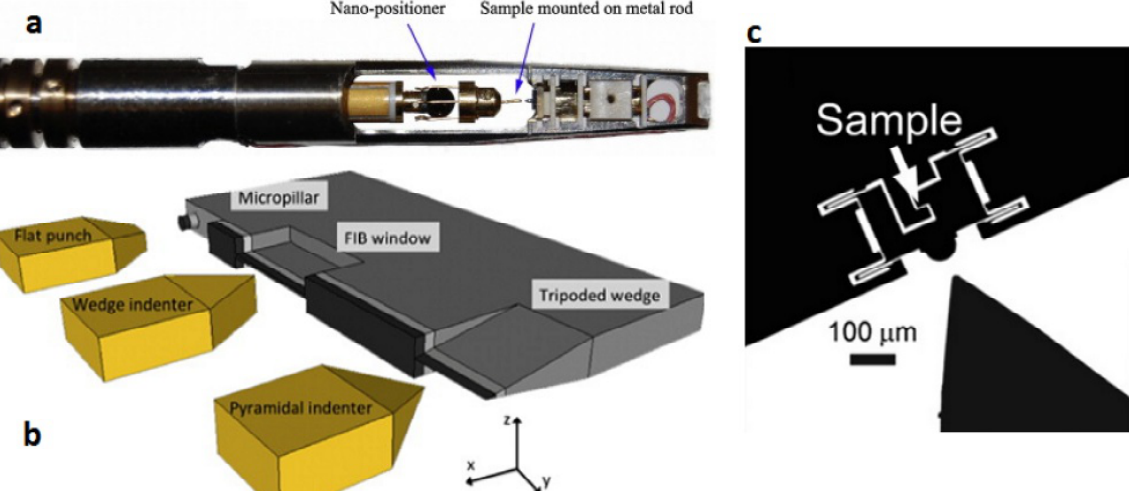
Fig. 4. Examples of in situ TEM mechanical testing techniques: (a) Tip of a classical straining holder (b) sketch of the various types of straining configurations used in nanoindentation holders, (c) Push to pull device with a Hysitron PI-95 nanoindenter. Reprinted with permission from: Legros M. 2014. In situ me- chanical TEM: Seeing and measuring under stress with electrons. Comptes Rendus Physique 15, [98]: (c) Elsevier Ltd. Carlton CE, Ferreira PJ. 2012. In situ TEM nanoindentation of nanoparticles. Micron 43 [105]: